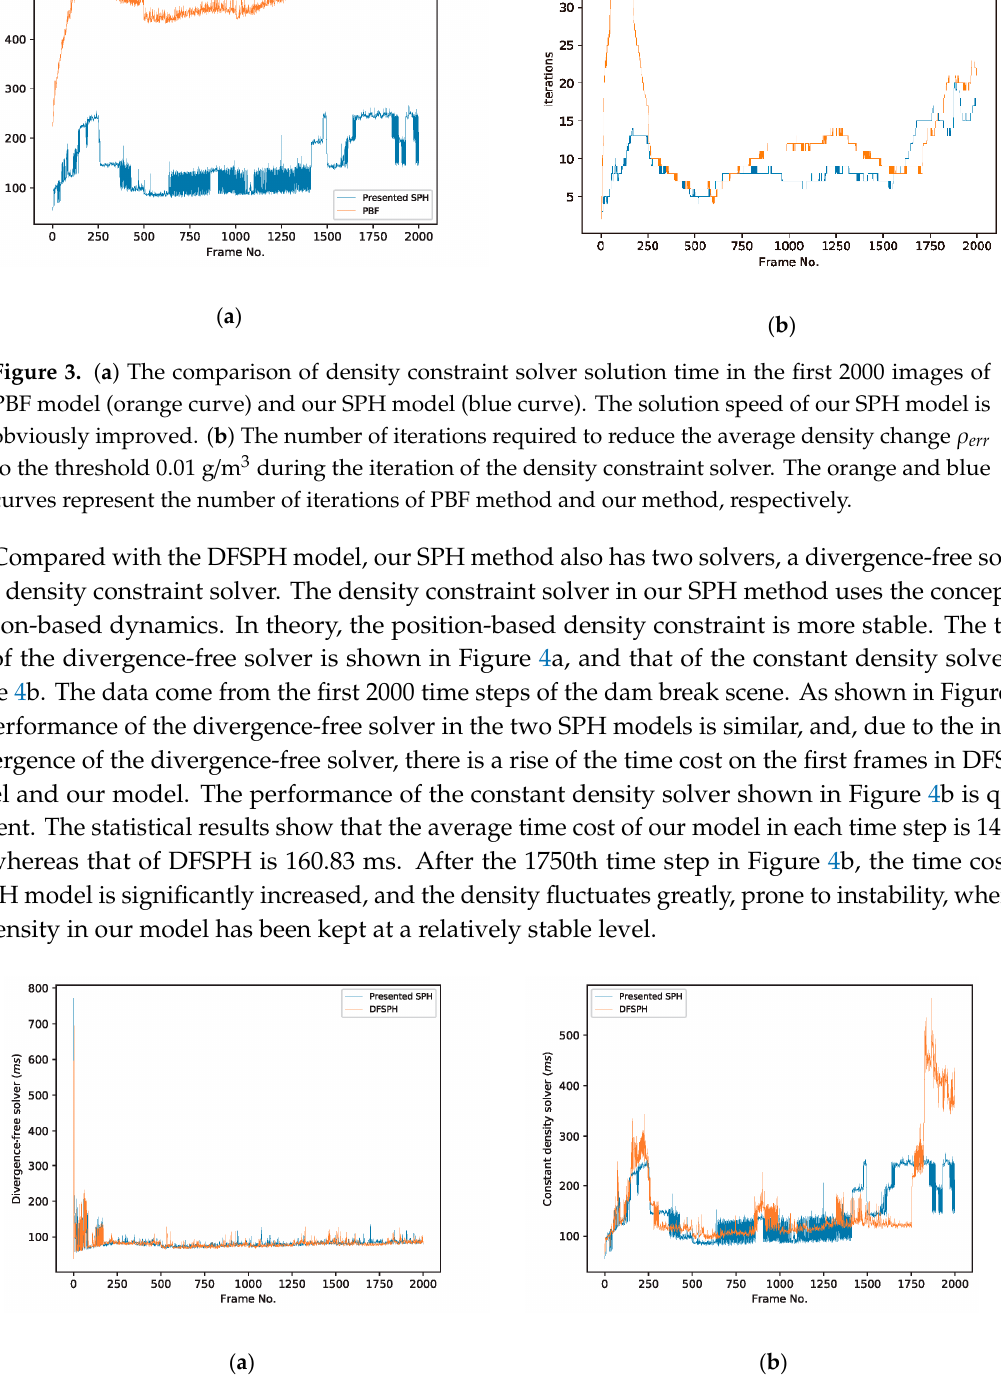
Figure 4. ( a ) The comparison of time cost of density constraint solver in DFSPH (orange curve) and our method (blue curve); and ( b ) the comparison of time cost of constant density solver (named density constraint solver in our method) in DFSPH (orange curve) and our SPH (blue curve) models.